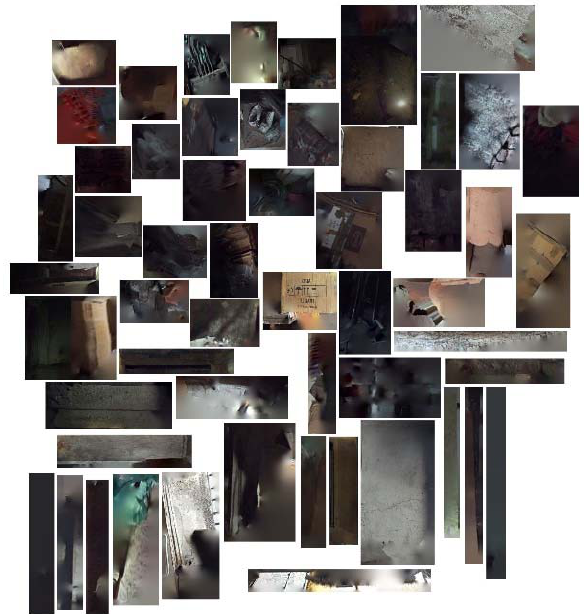
Figure 3: Mosaic of pictures taken by Matterport Pro2